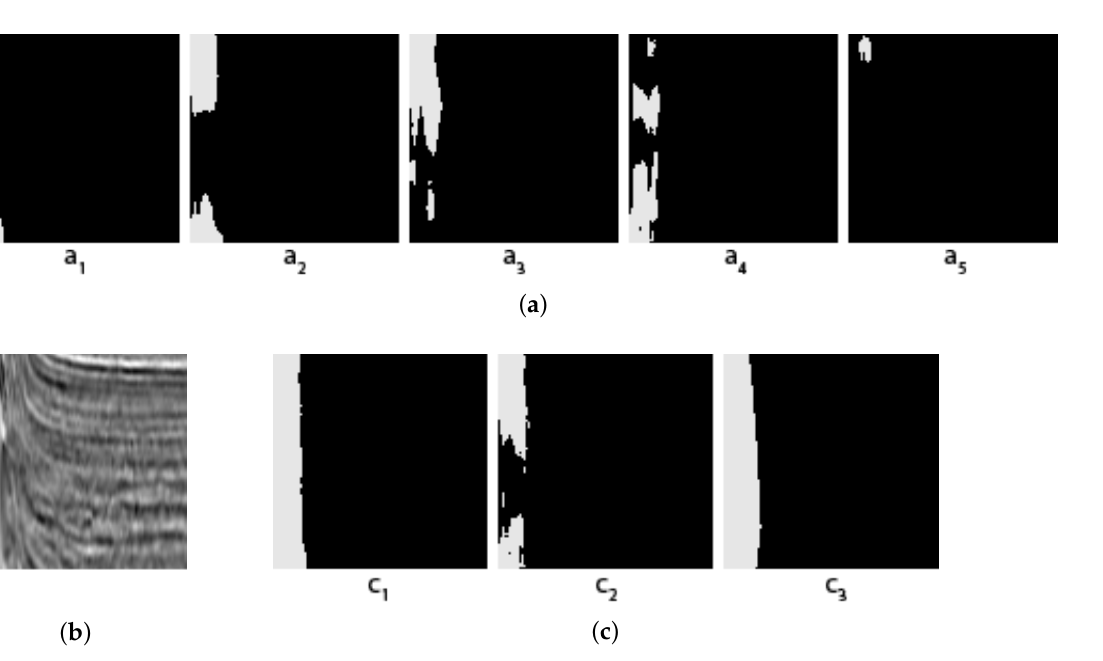
Figure 3. Topological vs. Arithmetical voting in salt segmentation—The first example. ( a ) (Masks created by 5 individual segmentors (from 5 folds); ( b ) Original image; ( c ) C 1 : Topological voting, C 2 : Arithmetical voting, C 3 : True mask.